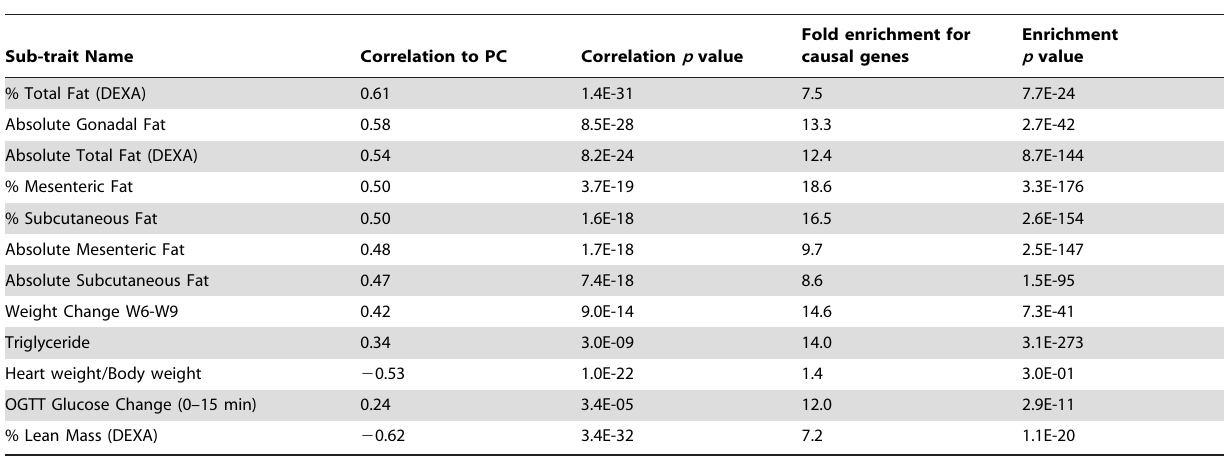
Table 2. Association of eQTL signature to trait QTL on chromosome 8.